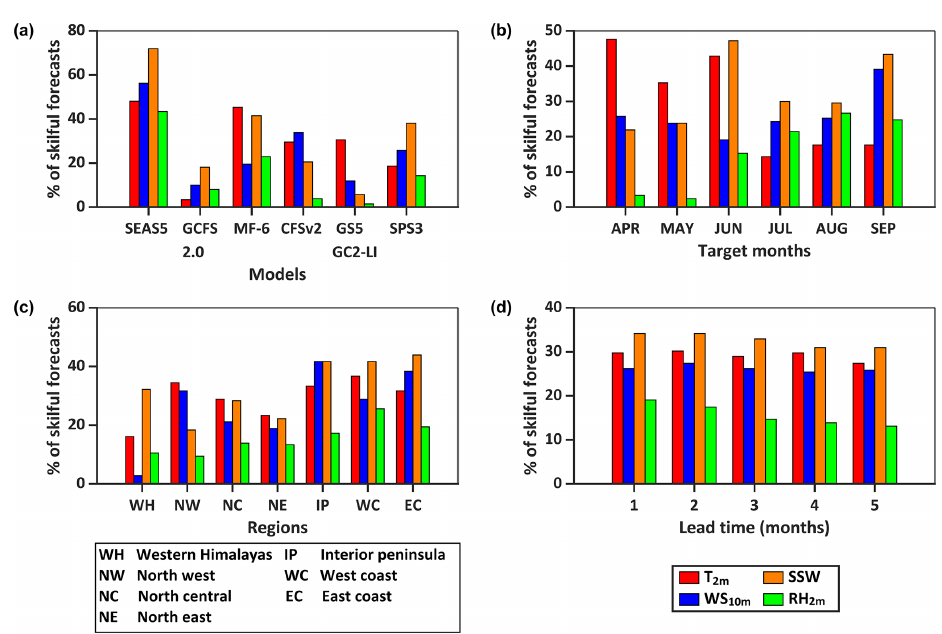
Figure 3. (a) Forecast performance for variables in different models. (b) Forecast performance for variables in different target months. (c) Forecast performance for variables in different regions. (d) Forecast performance for variables at different lead